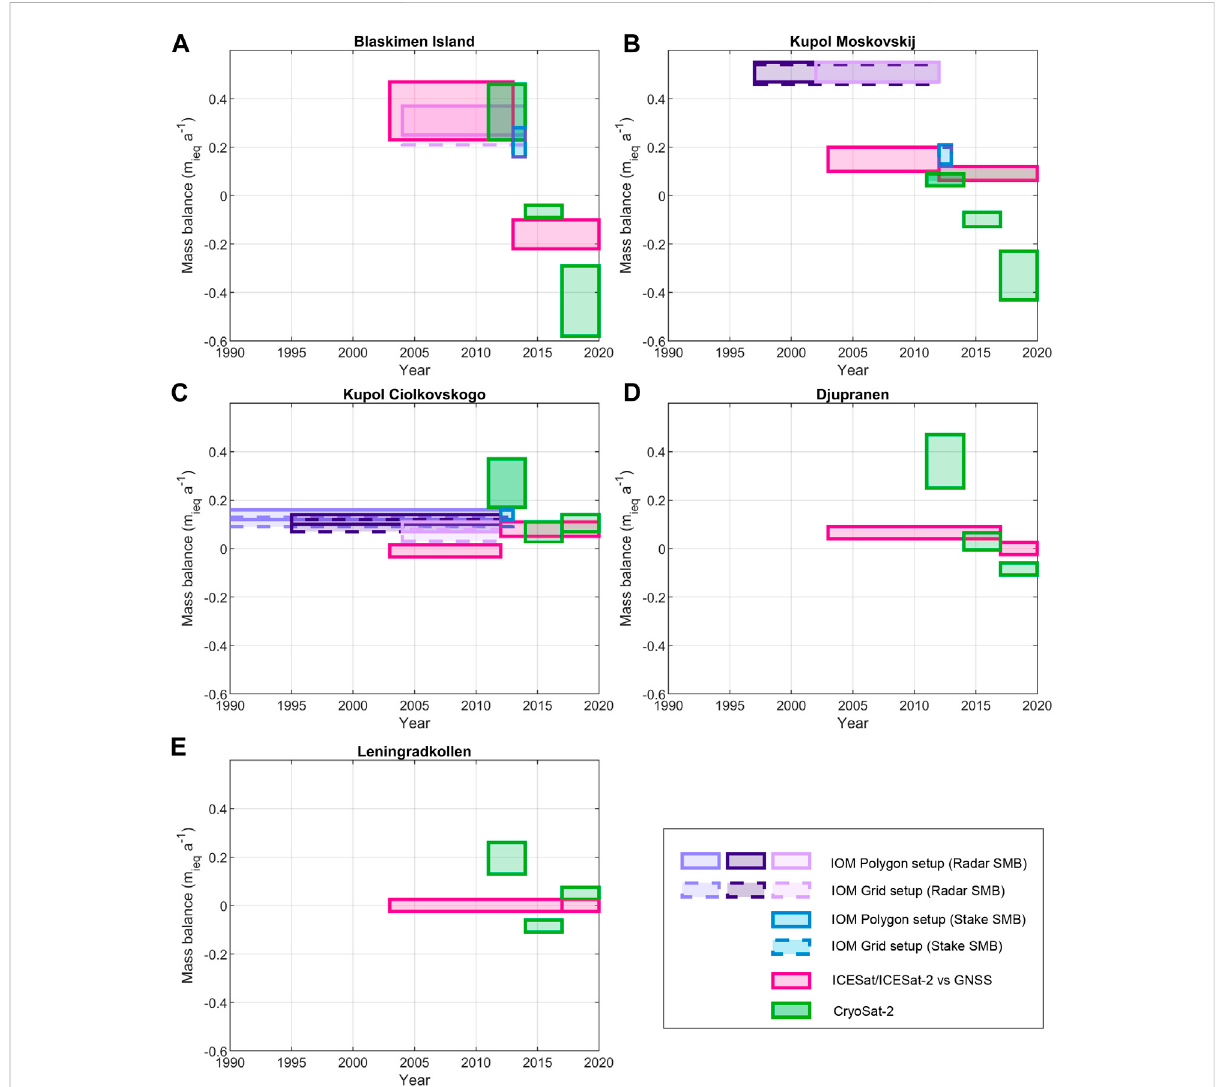
FIGURE 5 An overview of mass balance estimates over ice rises Blåskimen Island (A) , Kupol Moskovskij (B) , Kupol Ciolkovskogo (C) , Djupranen (D) and Leningradkollen (E) .Each boxrepresentsthetime interval (width) andtheuncertainty (height)oftheestimates.ThepolygonandgridIOM setupsuse thesamedatabutdifferinmethodologyandareshownascontinuousanddashedboxes,respectively.Asdiscussedinthepaper,wesuspectthatthe IOM estimate using radar-derived SMB for KM is